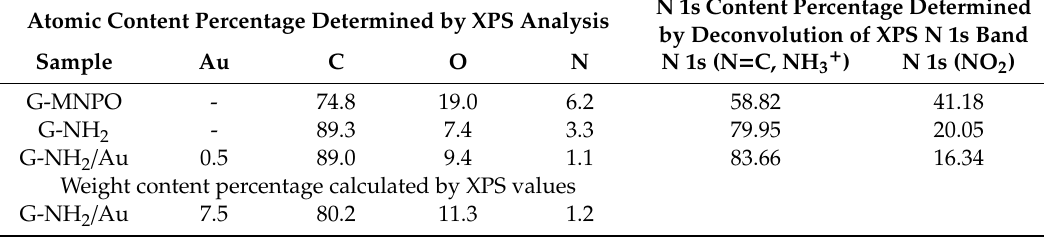
Table 1. Atomic content percentage for G-MNPO, G-NH 2 , and G-NH 2 /Au samples as determined by XPS analysis and N 1s percentage determined by deconvolution of XPS N 1s band. Weight content percentage of G-NH 2 /Au calculated by XPS values (at the bottom).